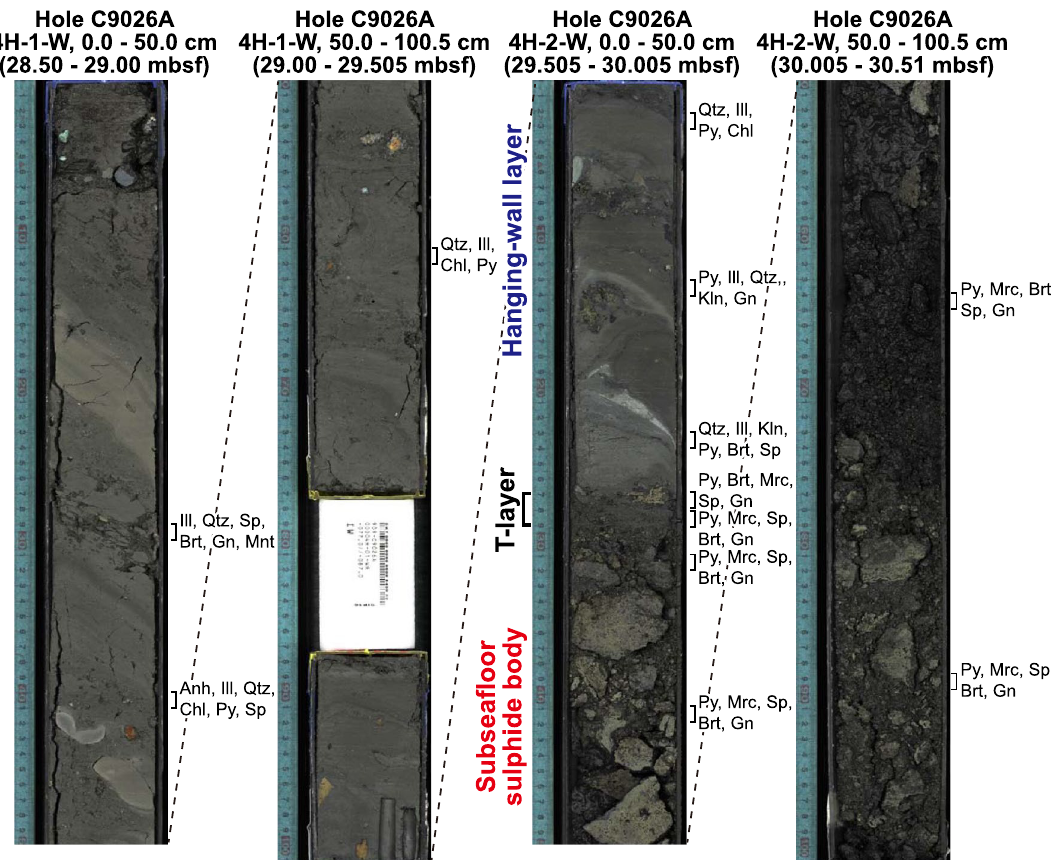
Figure 2. Scanned drill core images showing the contact between hemipelagic sediment and the sulphide body at Hole C9026A. The T-layer, composed of pyrite + barite + marcasite + sphalerite + galena, is 2 cm thick and is interpreted as a cap layer restricting hydrothermal fluid to lateral flow, controlling subseafloor sulphide mineralisation and hydrothermal alteration. Anh anhydrite, Brt barite, Chl chlorite, Gn galena, Ill illite, Kln kaolinite, Mnt montmorillonite, Mrc marcasite, Py pyrite, Qtz quartz; Sp,